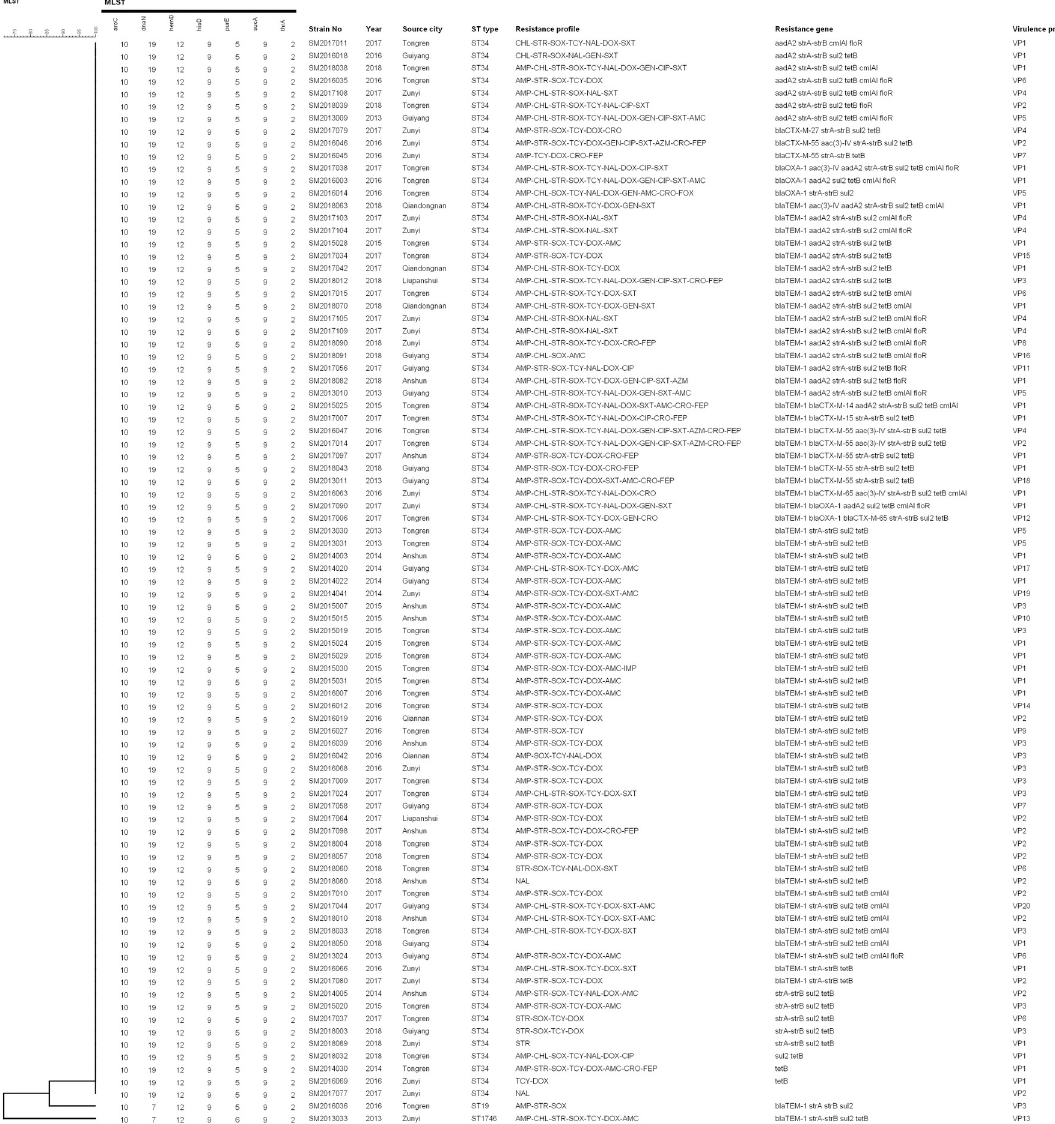
ST1746 and ST19 (purE6 replaced purE5).